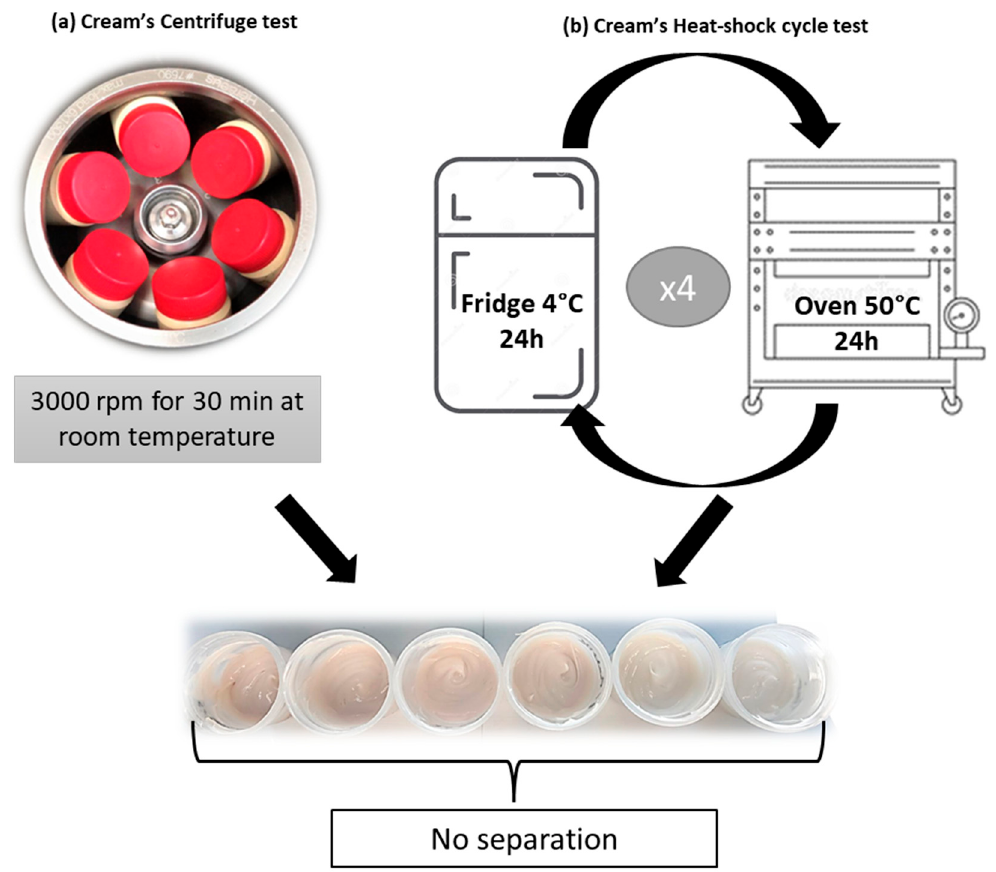
Figure 5. Schematic representation of the tests performed on creams containing 0, 2, 3, 4, 5%, Marse- lan extract, or 5% of the commercial extract: centrifuge test ( a ), heat-shock cycle ( b ) repeated four